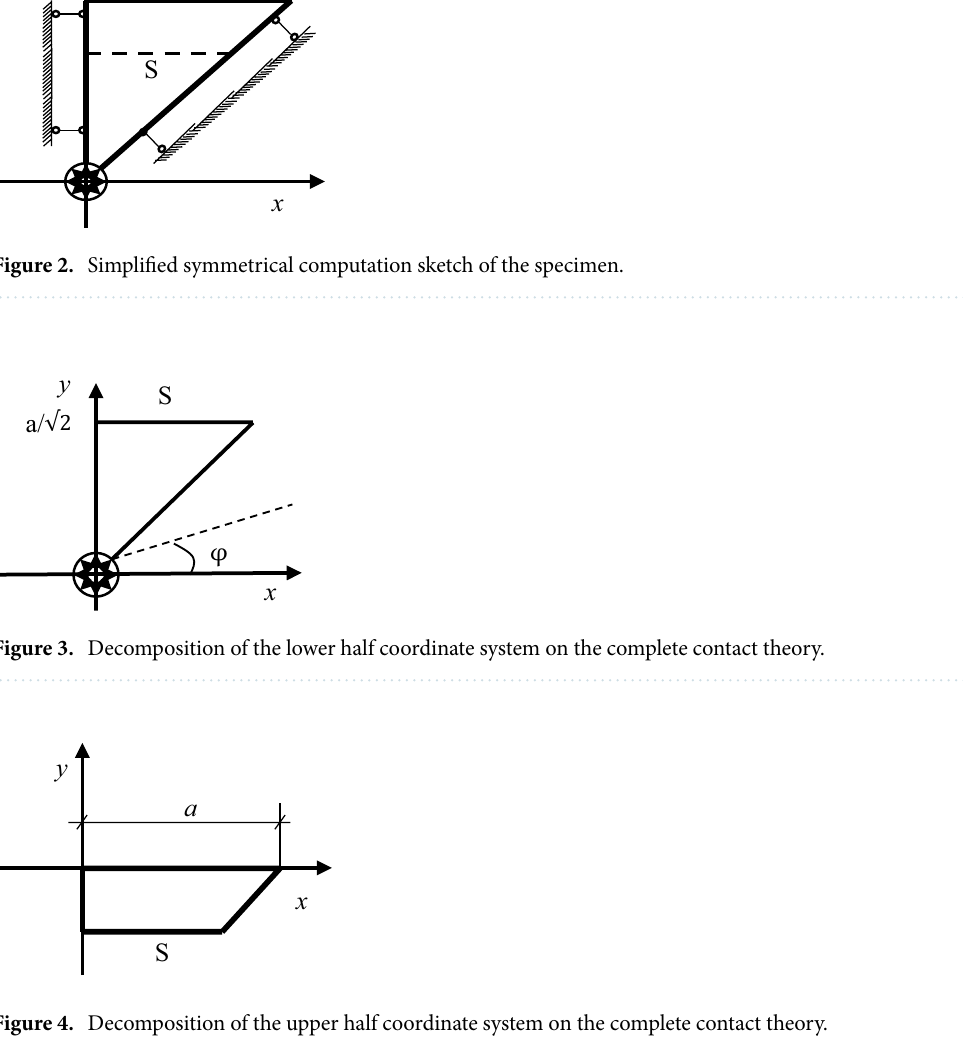
and Fig. 4, taking S-plane as the partition, the calculation diagram can be divided into two parts (the upper and the lower) for analysis. Coordinate systems are established, respectively. Besides, the S-plane boundaries in Figs. 3 and 4 fulfill the full contact condition of elastic mechanics. Figure 3 is to calculate the stress and strain on the S-plane in the polar coordinate system by using Lame’s solution, and to convert the stress and strain to the boundary condition on the S-plane in the rectangular coordinate system through the coordinate transformation as shown in Fig. 4. Meanwhile, Fig. 4 is to establish the relationship model between the expansion force of rein- forcement rust and the surface strain of concrete specimen by adopting the complete contact theory of elasticity in the rectangular coordinate system. Relationship between the expansion force of steel rust and the surface strain of concrete. In the coordinate system of Fig. 4, the semi inverse solution of elasticity is adopted. According to the boundary 0 is derived. However, with the increase of y , σ conditions, (σ y ) y deviates from 0. Therefore, assuming y 0 = =